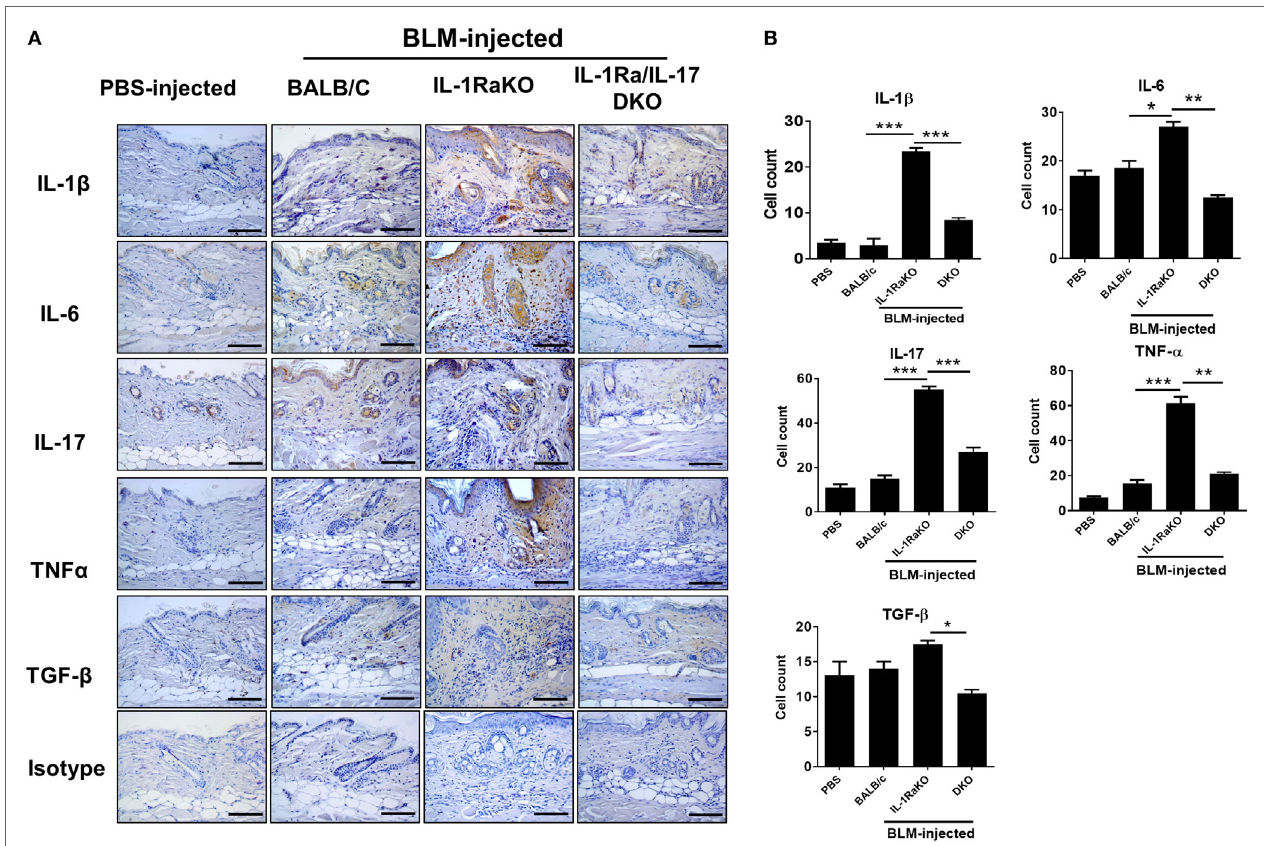
FigUre 3 | Inflammatory mediators in lesional skin. (a) Representative skin tissue section from the phosphate-buffered saline- or Bleomycin-injected mice were stained for IL-1 β , IL-6, IL-17, TNF- α , and TGF- β . Original magnification 400 × . Scale bar represents 100 µm. (B) Positive cells are indicated in the bar graphs. The data are expressed as the mean ± SEM for three independent experiments per group. * p < 0.05, ** p < 0.01, *** p <